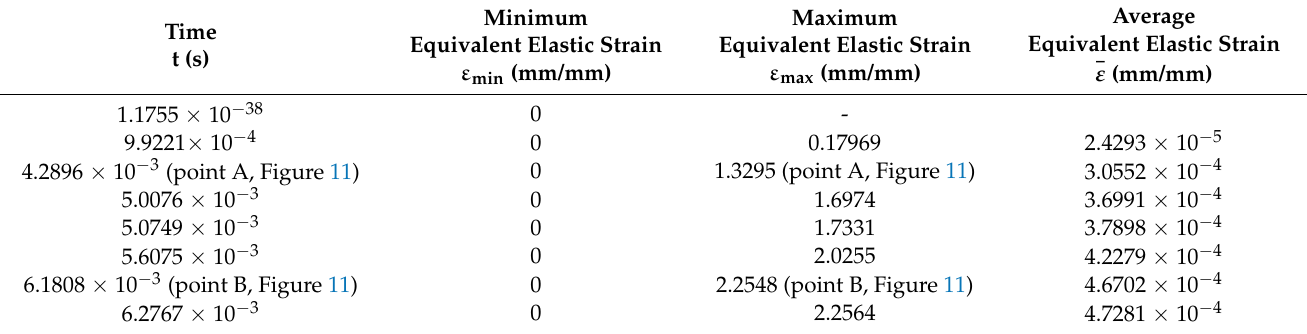
Table 4. Equivalent Elastic